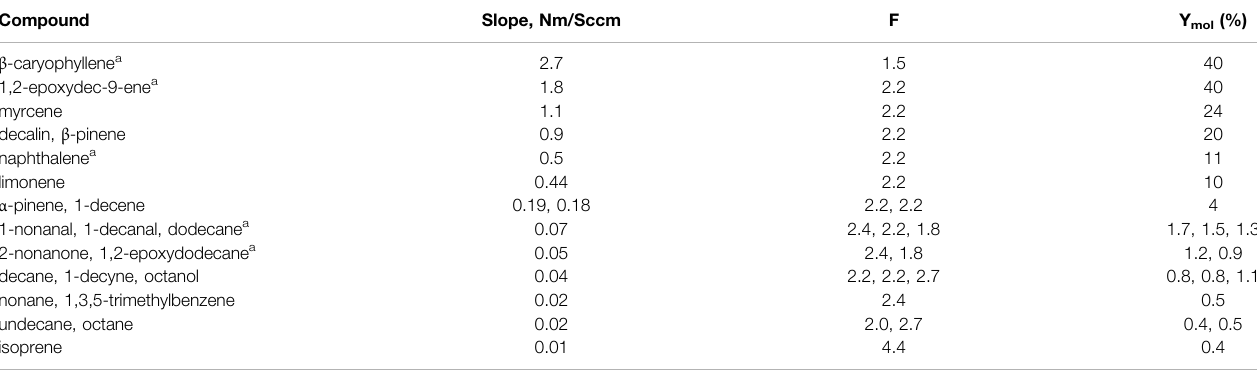
TABLE 1 | SOA Yields for Organic Compounds Examined in GroFR. All species in the last six rows are straight chains except for trimethylbenzene and isoprene. Density of the SOA was assumed to by 1.2 g cm − 3 for all species and molar mass was assumed to have an O:C ratio of